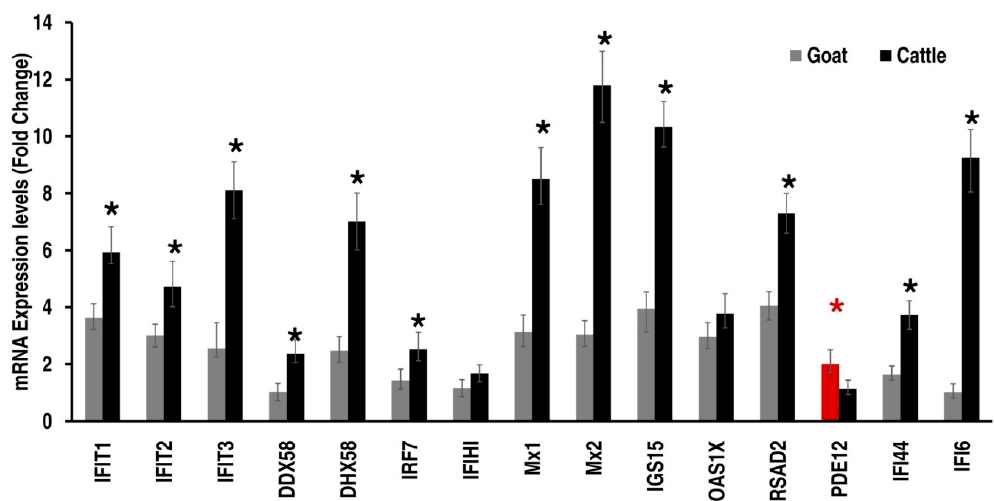
Figure 5. Validation of the differentially expressed ISG induced transcripts by RT-qPCR by SYBR Green chemistry. The PBMCs of goat and cattle were infected with PPRV at 1 MOI and RT-qPCR was performed on the 24 h PI, using the primers listed in Table 1. PPRV infection resulted in significantly increased levels of IFIT1, IFIT2, IFIT3, DDX58, DHX58, IRF7, MX1, MX2, IGS15, RSAD2, IFI44 and IFI6 in cattle, while PDE12 significantly increased in goat PBMC upon PPRV infection. (* indicates p < 0.05 determined by paired t-test and results of n = 5 samples).